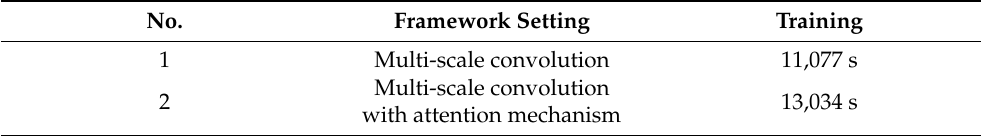
Table 8. The time of filtering the ISPRS dataset by the model with or without the attention mechanism. No. Framework